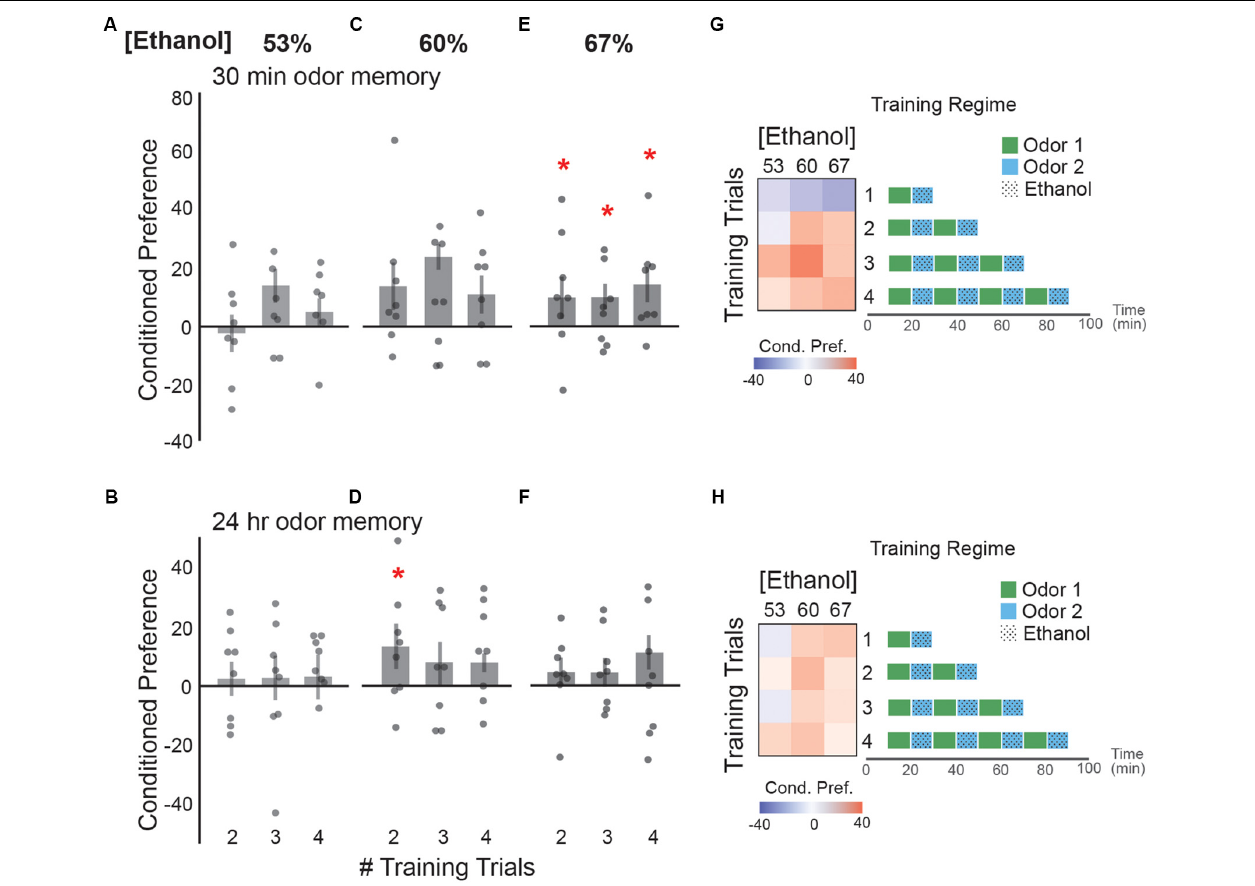
FIGURE 3 | Binge-like alcohol-odor pairings results in an appetitive ethanol preference. No statistically significant ethanol preference is observed (A) 30 min post-training or (B) 24 h post-training with two, three, or four consecutive training trials of 53% ethanol. (C) Two [ t (13.37) = − 2.14, p = 0.051] or three [ t (12.88) = − 2.11, p = 0.054] consecutive doses of 60% ethanol trend towards an appetitive ethanol preference 30 min. (D) There is an observed 24 h ethanol preference following two, but not three or four consecutive doses of 60% ethanol [ t (13.86) = − 2.33, p = 0.04]. (E) Appetitive ethanol preference is observed at 30 min following two [ t (13.89) = − 2.26, p = 0.04], three [ t (13.89) = − 2.26, p = 0.04] or four [ t (12.98) = − 2.35, p = 0.03] consecutive doses of 67% ethanol. (F) No significant ethanol preferences are displayed 24 h following two, three, or four consecutive doses of 67% ethanol. (G) A heat map summary of the data from both the single exposure training and binge-like training demonstrates that binge-like training results in trend towards an appetitive ethanol preference at 30 min with multiple consecutive pairings. Schematic of the training paradigms are depicted. (H) A heat map summary of conditioned preference at 24 h post-training suggests very little lasting appetitive preference regardless of concentration and number of training trials. Bars represent mean + / − standard error. N ∼ 8 per group where individual data points represent N = 1 ( ∼ 100 flies) CPI. ∗ p <